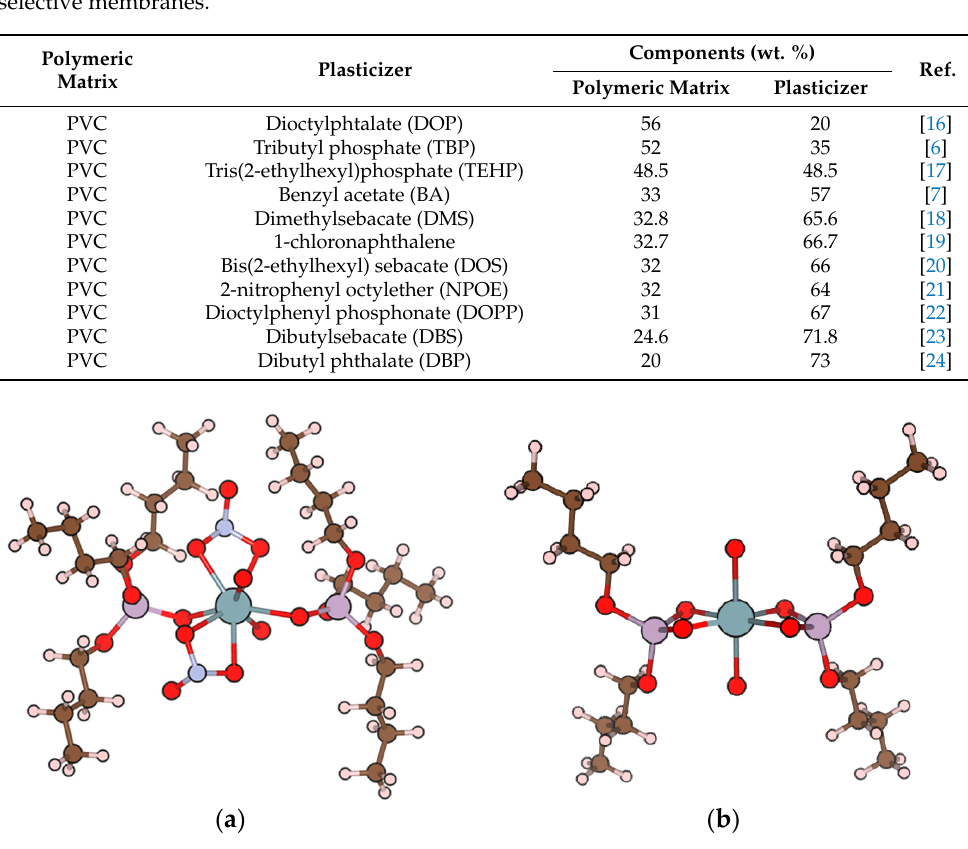
Figure 4. Configuration of uranyl coordinated by ( a ) TBP and ( b ) DBP.